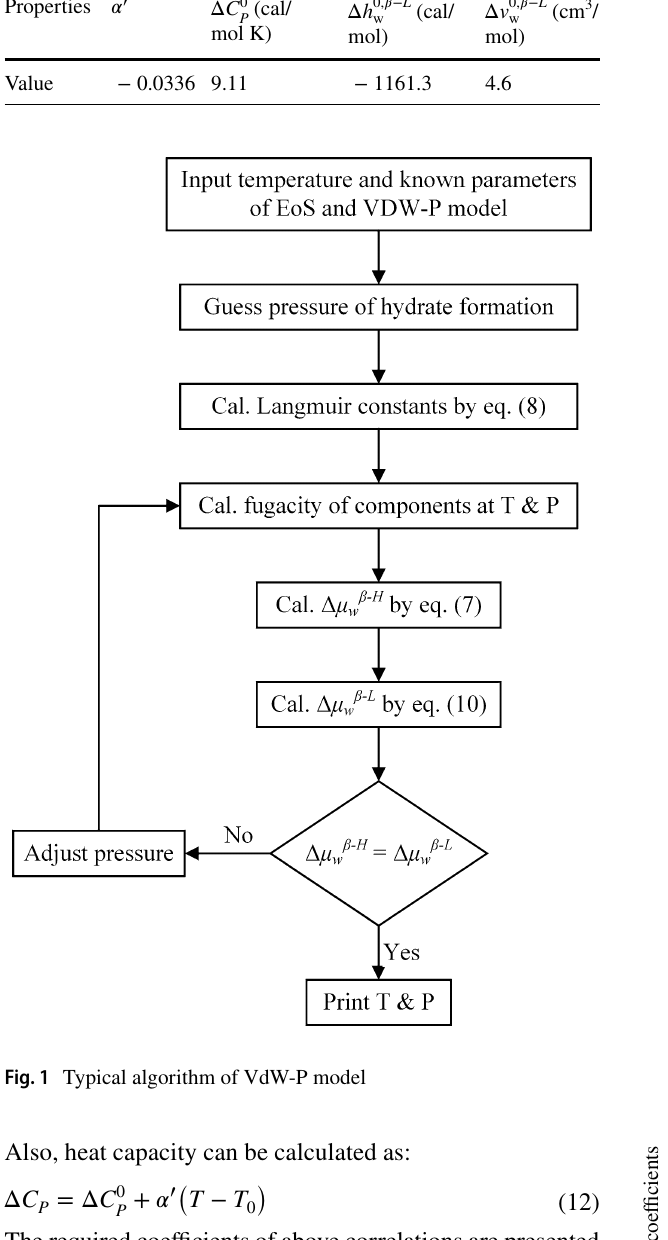
Table 2 Thermodynamic parameters of VdW-P Properties 𝛼 ′